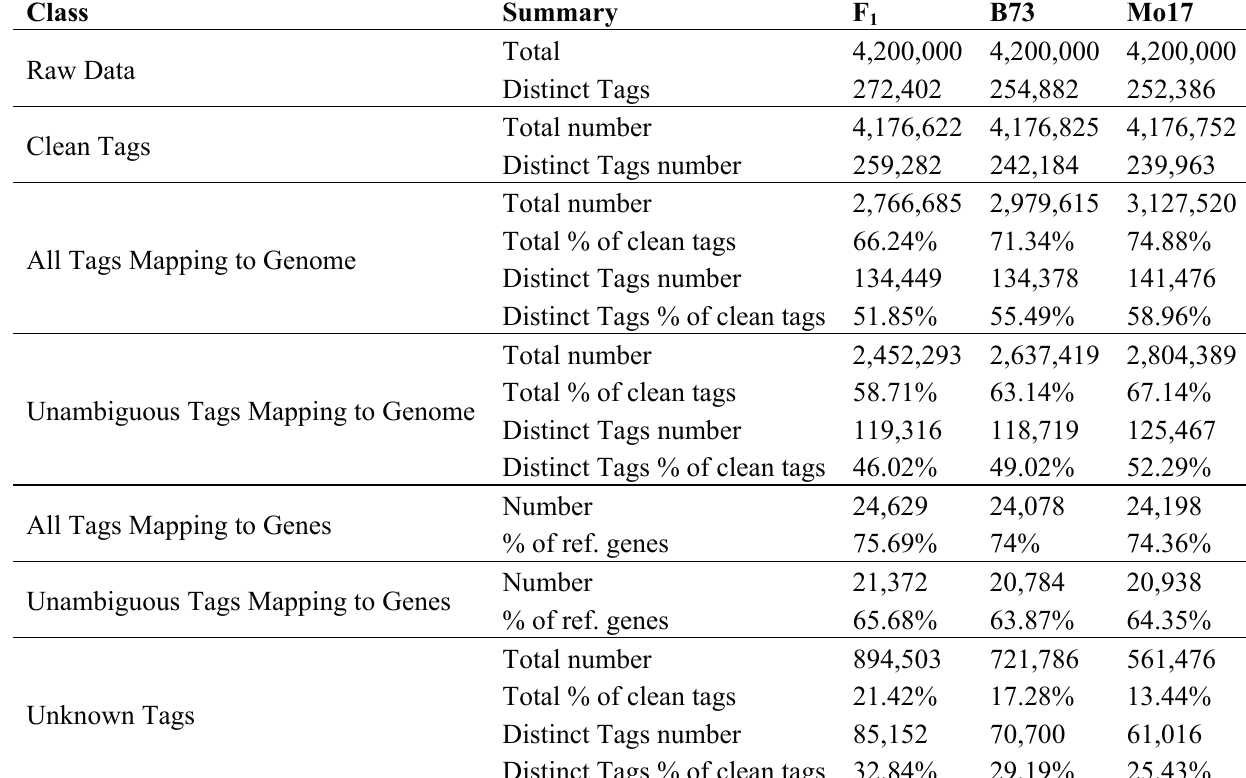
Table 1. Summary statistics from mapping digital gene expression (DGE) sequence tags to the maize B73 reference